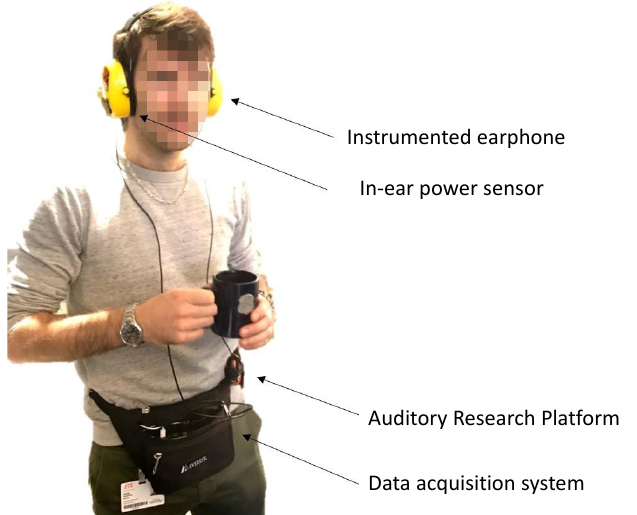
Figure 3. Test subject wearing the in-ear power sensor device and the Auditory Research Platform